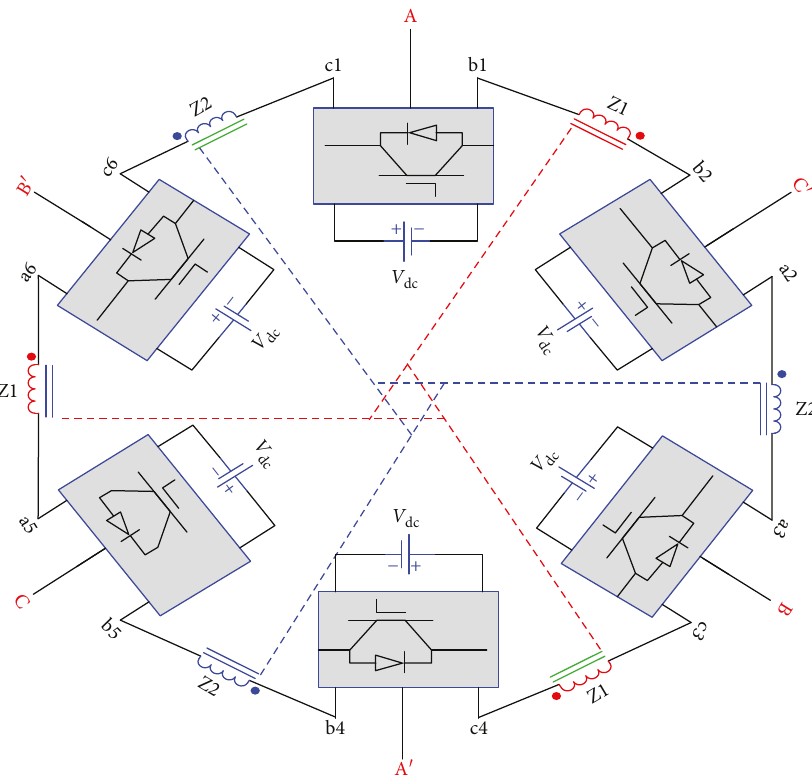
Figure 12: The HMC with two three-winding coupled